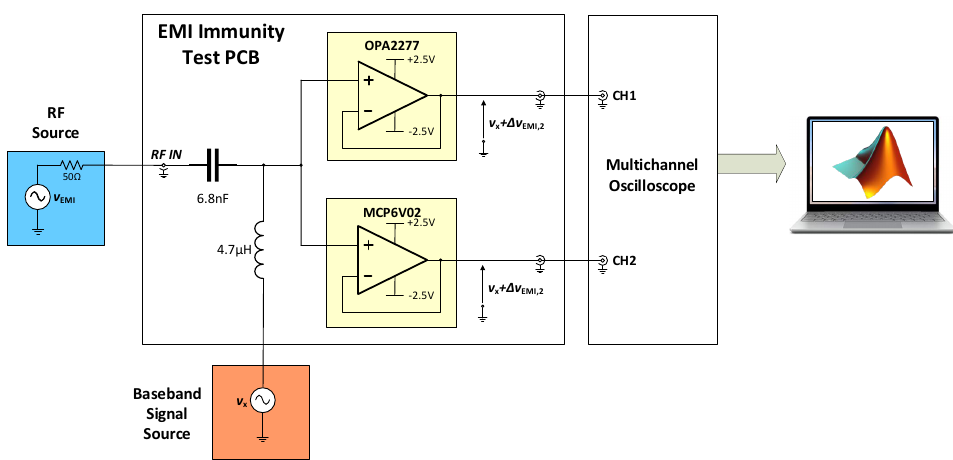
Figure 3. Acquisition Front-End Test Bench block diagram, with detail of the fabricated EMI test